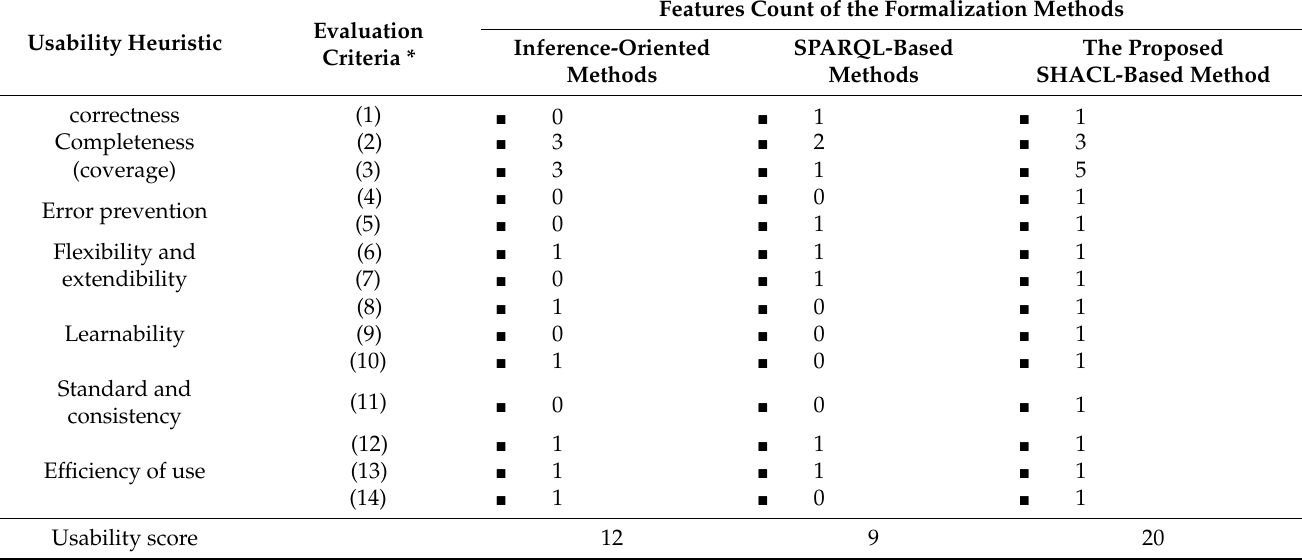
Table 7. Results of the usability evaluation of the formalization